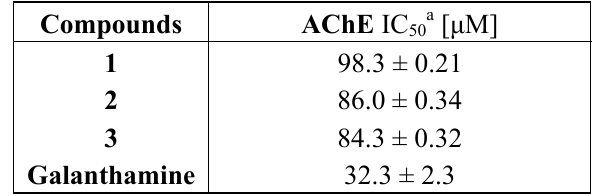
Table 3. In vitro inhibition of AChE by compounds 1 – 3